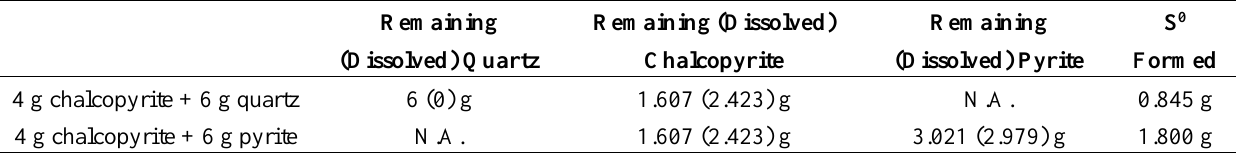
Table 2. Initial and final weights of mineral phases for the flow-through leach experiments. It